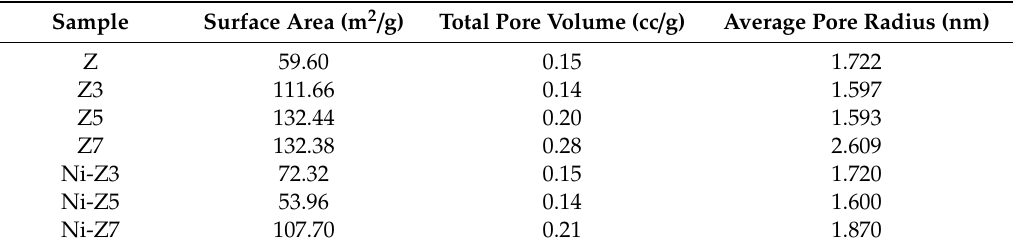
Table 3. Specific surface area, pore volume, and average pore radius of Z, Z3, Z5, and